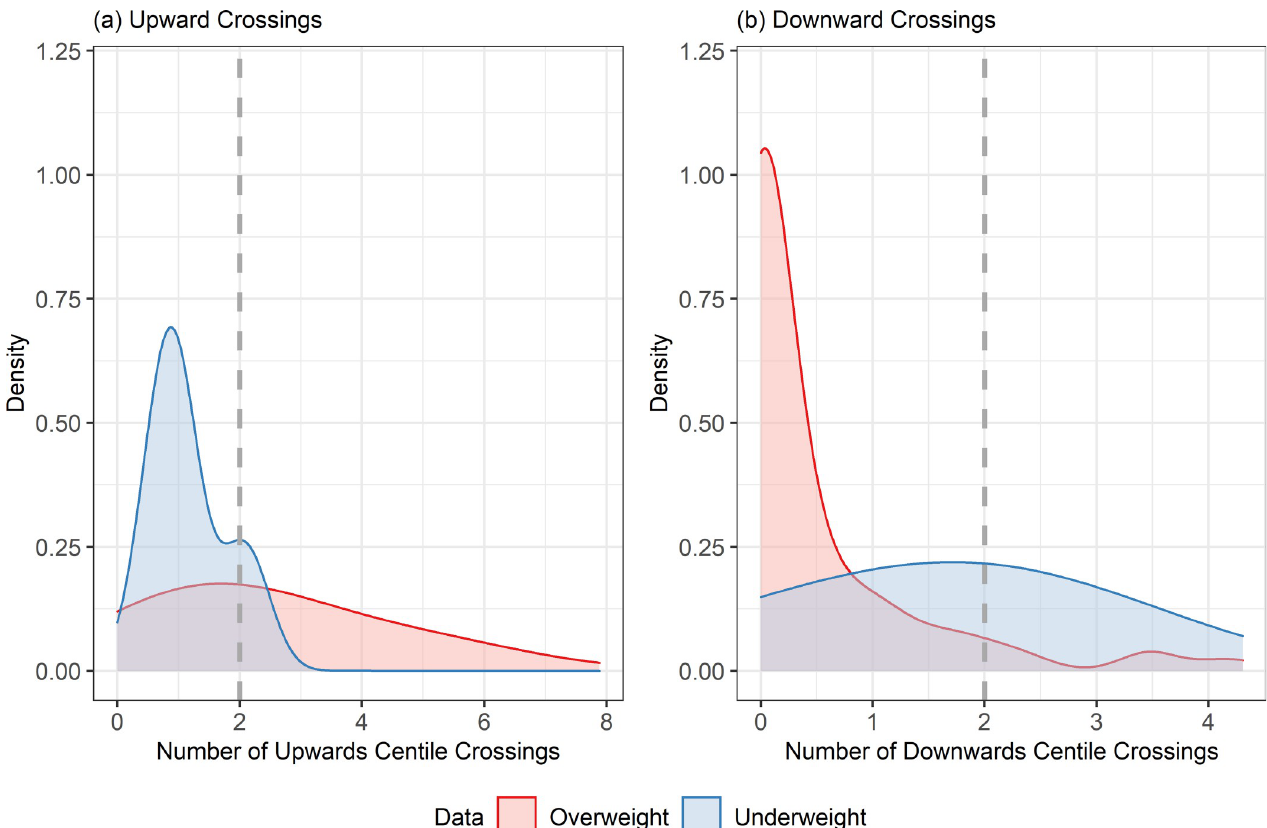
Fig 5. Density distribution of the number of standard centile lines crossed in an (a) upwards and (b) downwards direction for DSH kittens. Plots only include those with at least 3 weight measurements over 6 months in the age range 8 to 78 weeks old in the underweight subset (blue) and overweight subset (red). The vertical dotted line indicates 2 centile